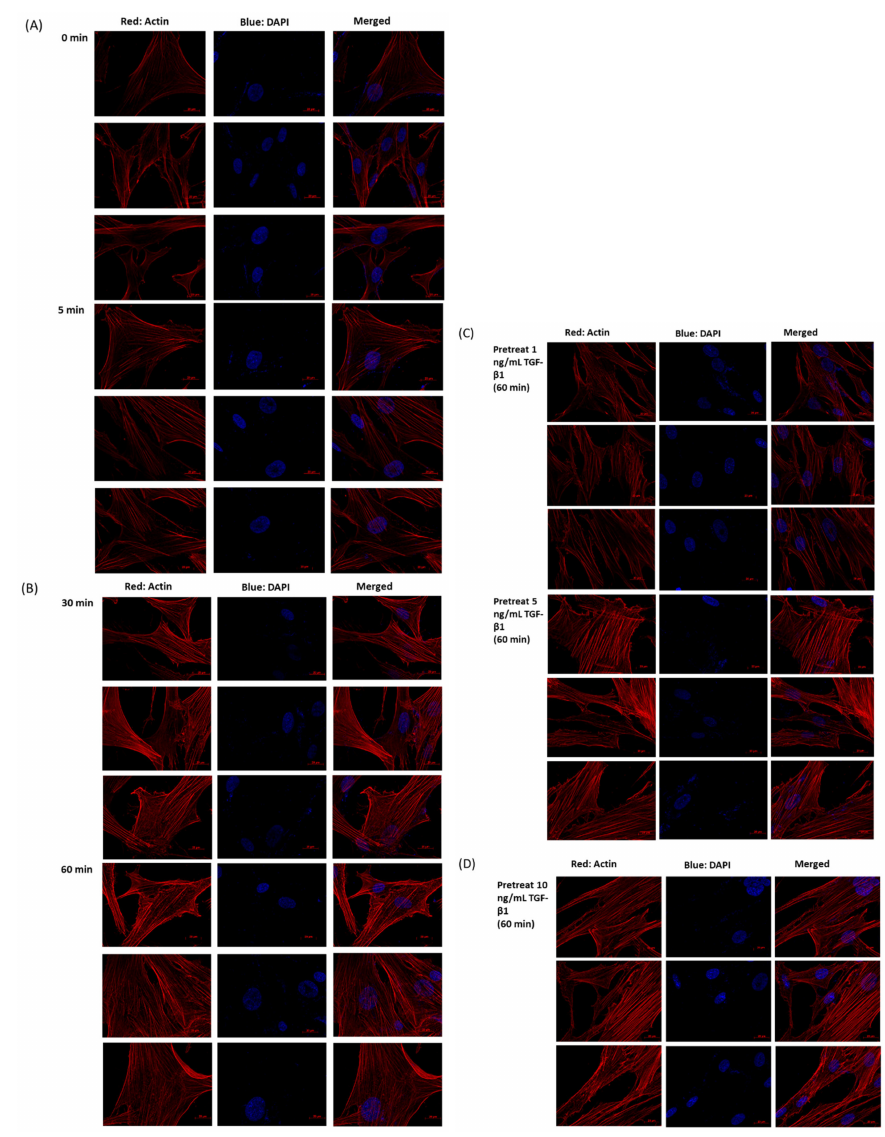
Figure 3. Immunofluorescence analysis of H 2 O 2 (1 mM)-treated HTMCs. Photomicrograph of HTMCs with H 2 O 2 -treatment for ( B ) 30 and 60 min expressing more abnormal stress fiber formation, i.e., much denser and thicker compared to the ( A ) control and at a 5 min duration. HTMCs were treated with H 2 O 2 on 12 mm coverslips for various exposure times (5, 30, 60 min) and were fixed and stained with phalloidin and 4 (cid:48) ,6-diamidino-2-phenylindole (DAPI). ( C , D ) HTMCs pretreated with rhTGF- β 1 in different concentrations (1, 5, 10 ng/mL) were observed for the prevention of fibrosis. The same exposure was used for each set of fields and the images are reflective of three different fields (scale bar = 20 µ